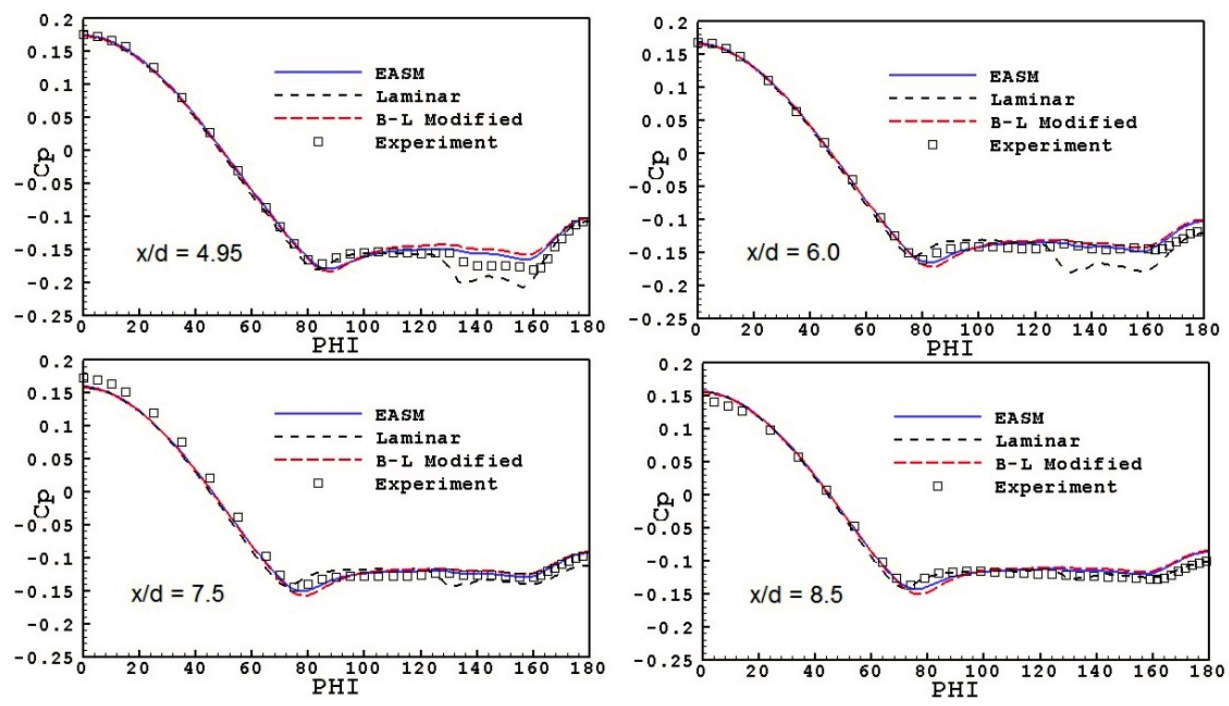
Figure 13. Ogive-cylinder: comparison of wall pressure coefficient at various cross sections. Reynolds number based on diameter.